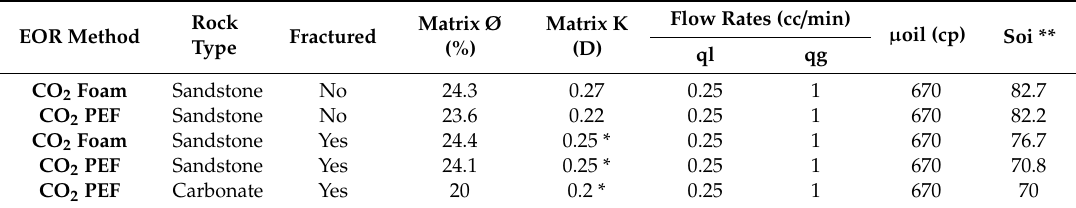
Table 1. Summary of rock properties and injection